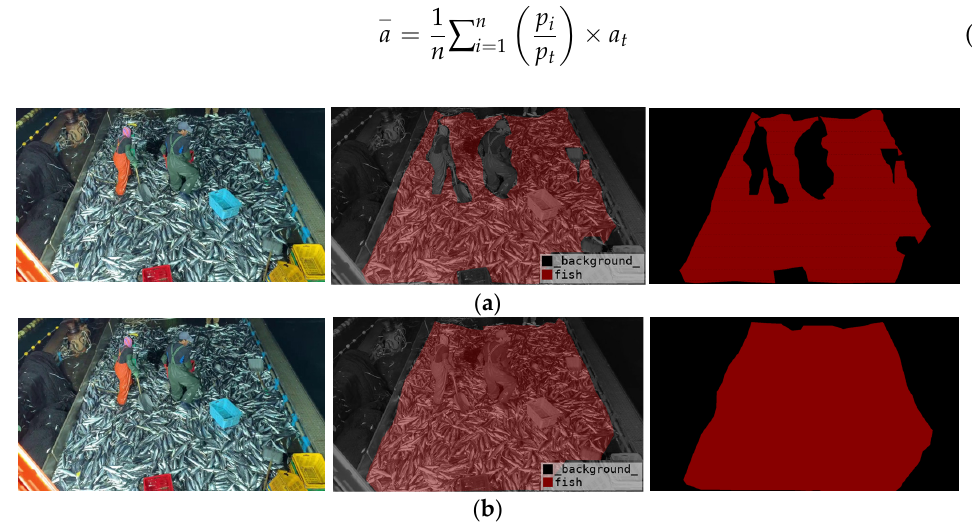
Figure 11. Labeling regarding segmentation: ( a ) is considering the person and others in labeling; ( b ) is not considering other objects.